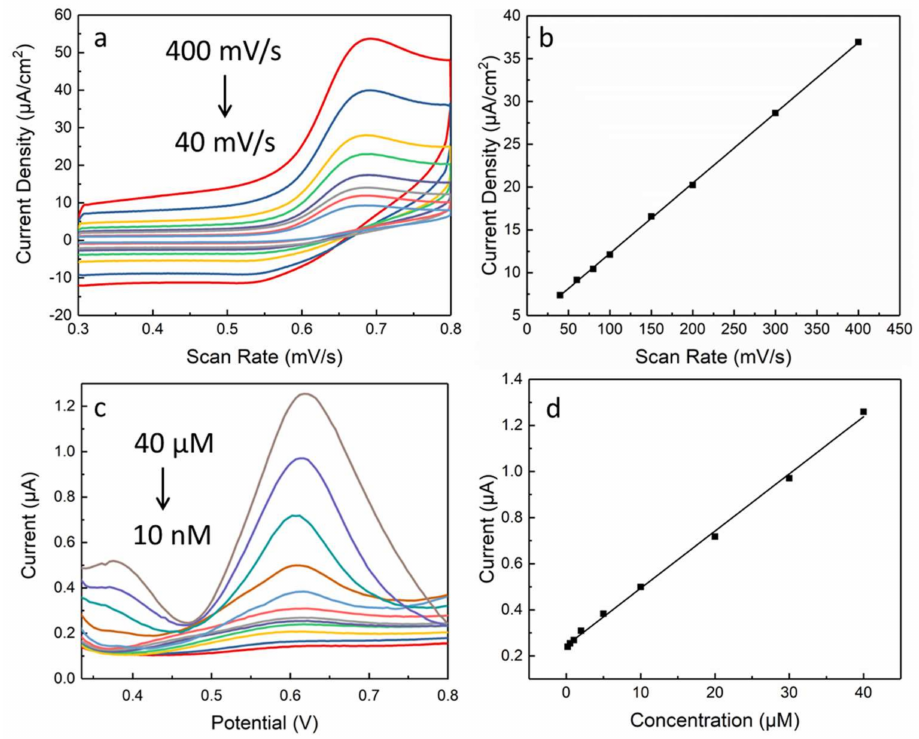
Figure 3. ( a ) CV responses of AuNP/graphene electrodes after 4-min electrodeposition in 50 µ M vanillin/PBS buffer with various scan rates and ( b ) the corresponding current density of oxidation peak. ( c ) DPV curves of AuNP/graphene electrodes with different vanillin concentrations and ( d )